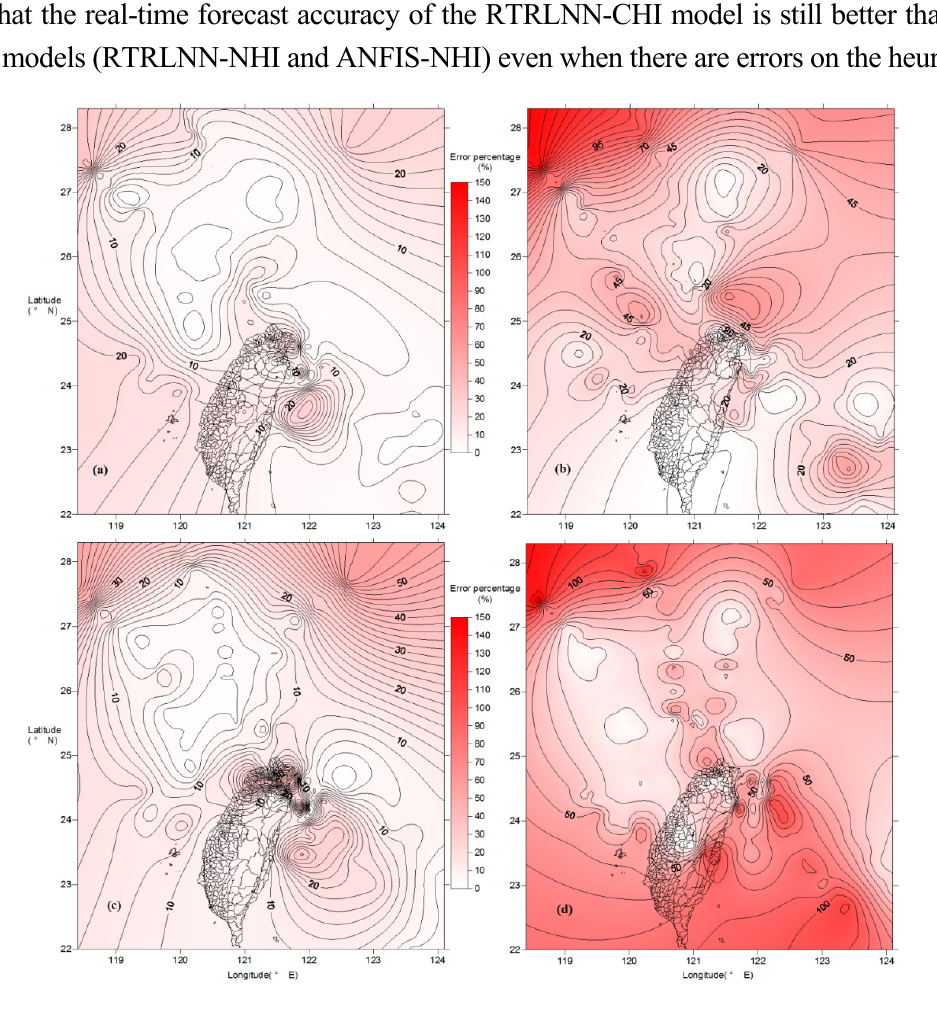
Figure 14. Comparison of spatial forecasted error feature of the four developed accumulated total inflow forecast models for the Shihmen Reservoir with relation to the typhoon central location: ( a ) RTRLNN-CHI model; ( b ) RTRLNN-NHI model; ( c ) ANFIS-CHI model; and ( d ) ANFIS-NHI